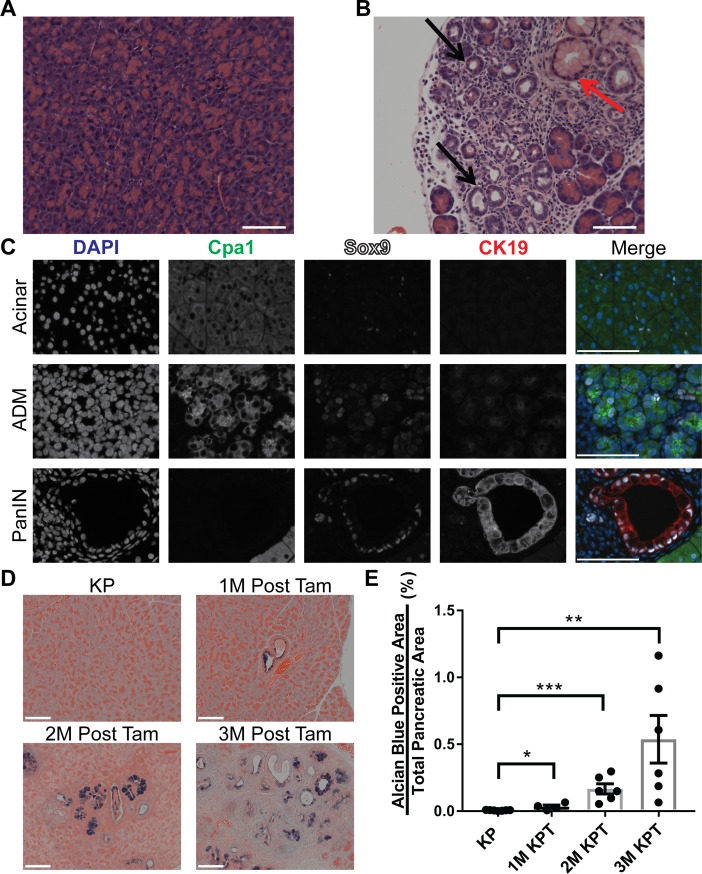
ADM and PanIN lesions precede tumor formation in KPT mice.(A-B) Representative micrographs depicting H&E stained sections of the pancreata of KP (A) and KPT (B) mice 3 months post tamoxifen treatment. Black arrows indicate regions of acinar to ductal metaplasia, red arrow indicates PanIN lesion. (n = 6 KPT mice, and n = 7 KP mice), magnification 20x. (C) Representative multiplexed IF micrographs of KPT pancreata 2 months post tamoxifen treatment, for detection of nuclei (DAPI, blue), Cpa1 (green), Sox9 (white) and CK19 (red). Images depict acinar tissue with normal histology (upper panels), an isolated region of early acinar to ductal metaplasia (middle panels) and a PanIN lesion (lower panels), n = 6 KPT mice, magnification is 63X. (D) Representative micrographs of alcian blue and eosin (AB/E) stained sections of the pancreata of KPT and KP littermate control mice 1M, 2M, and 3M post tamoxifen injection, magnification is 20X. (E) Whole slide quantification of alcian blue positive area relative to eosin positive total pancreatic area, data points represent 1 AB/E stained slide per mouse, n = 7 for KP mice, n = 4 for 1M KPT mice, n = 6 for 2M KPT, n = 6 for 3M KPT. Bars depicts mean with error bars representing standard error of the mean (SEM). Significance was determined by student’s t test. *, P < 0.05; **, P < 0.01; ***, P < 0.001. All scale bars represent 100 μm.